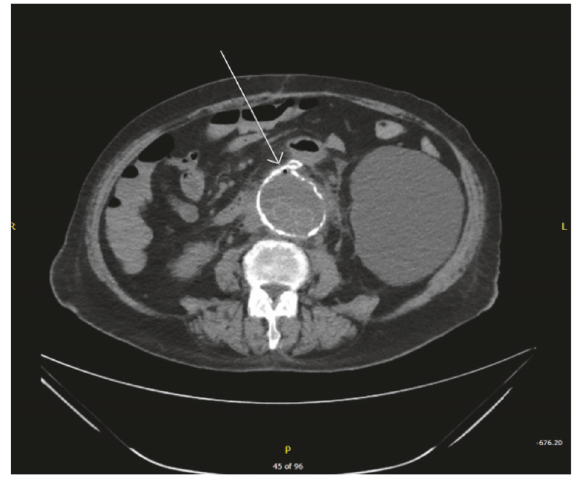
Figure 2: Computed tomography of abdomen showing tiny foci of air at the anterior aspect of the native aneurysm wrap just inferior to the location where the duodenum